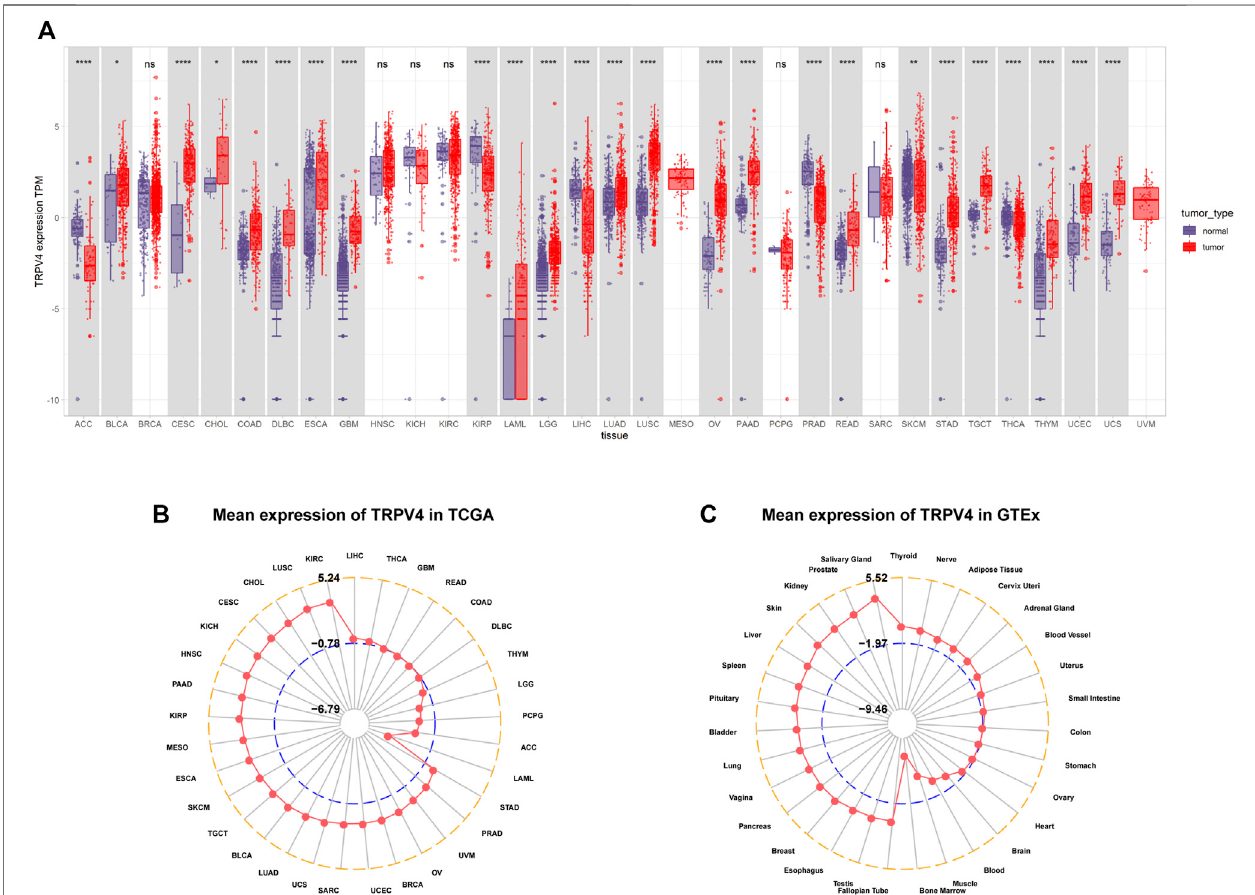
FIGURE1| Pan-cancerTRPV4expressionanalysis. (A) Pan-cancerTRPV4expressionbetweentumortissuesfromTCGAandnormaltissuesfromTCGAandthe GTEx database. (B) Radar plot shows TRPV4 expression levels in tumor tissues from TCGA. (C) Radar plot shows TRPV4 expression levels in normal tissues from the GTEx